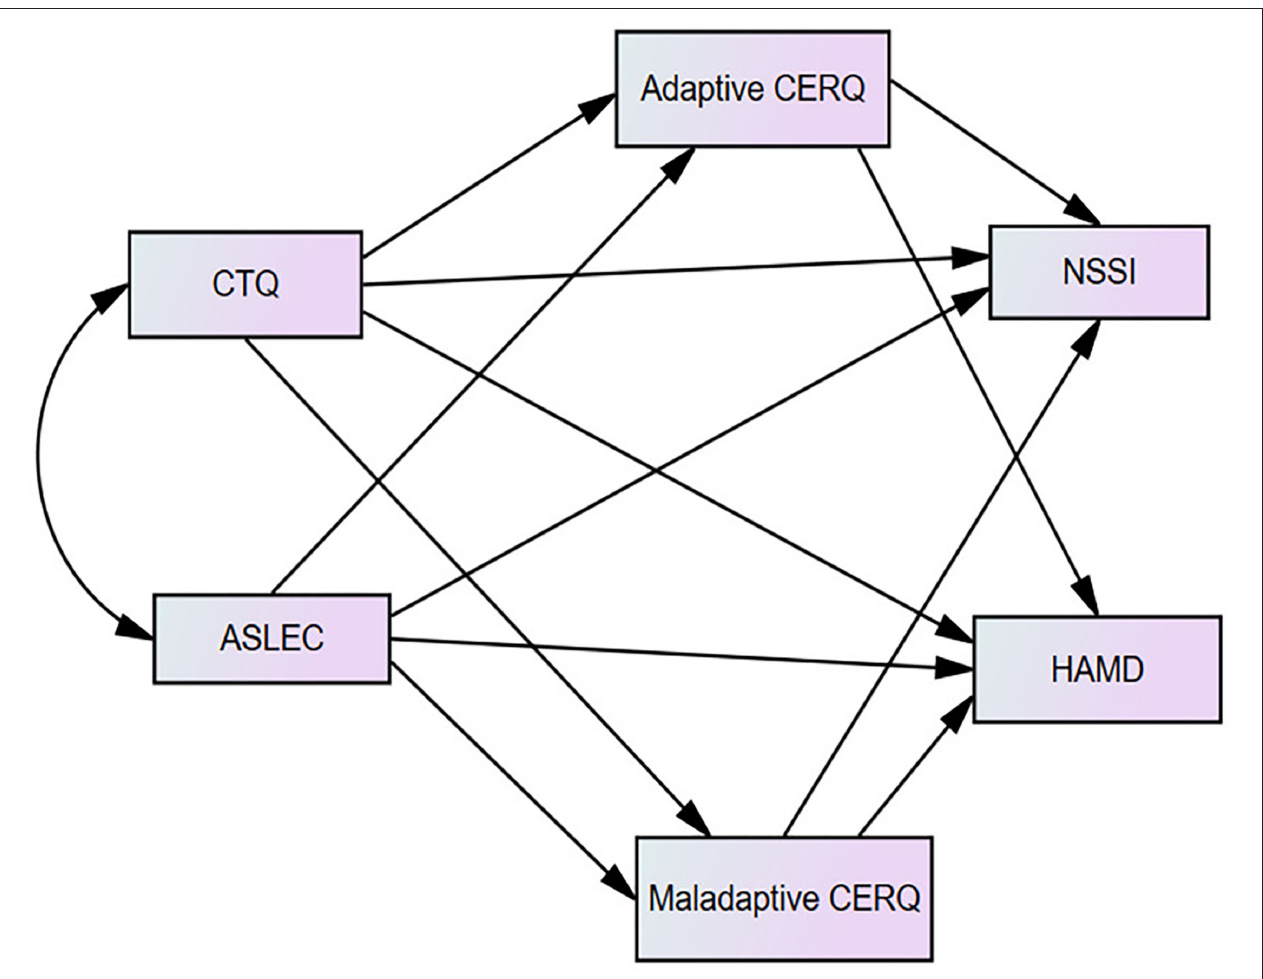
FIGURE 1 | The hypothetical model of the mediating role of adaptive and maladaptive cognitive emotion regulation questionnaire